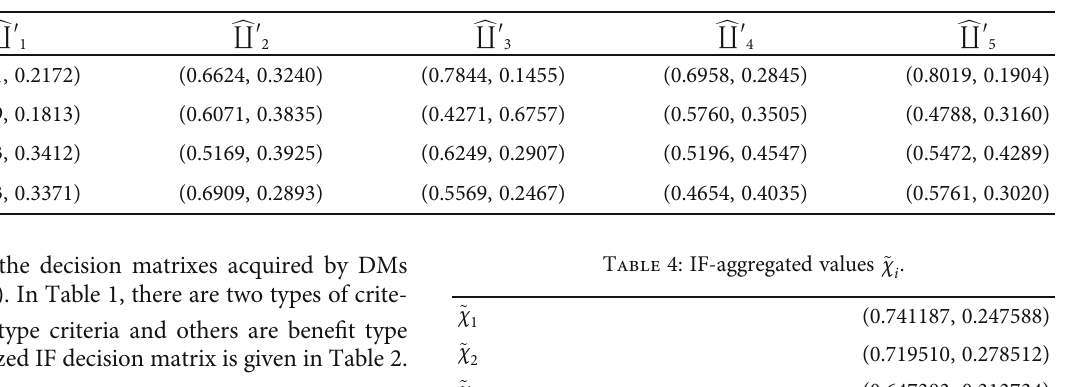
Table 3: Combined evaluation matrix.